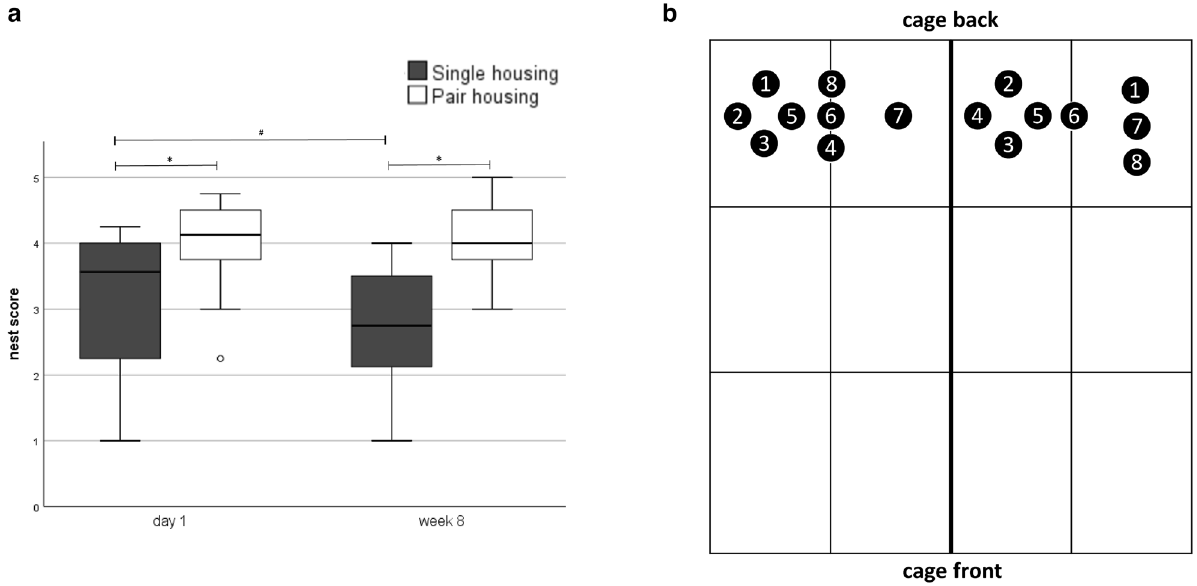
Figure 4. Nesting. ( a ) Nest complexity scores: Data are presented as boxplot diagrams: the box represents the interquartile range (IQR), box edges are the 25th and 75th quartile. The whiskers represent values which are not greater than 1.5 × IQR. Dots are outliers with values between 1.5 ‒ 3.0 × IQR. * p < 0.05 versus pair housing. Single housing: n = 16, pair housing: n = 16. ( b ) Nest positions in the pair housing system: the cage compartments were divided into six units. The numbers symbolize the unit/border where the nests were built. For nests of both mice of a pair, the same numbers were used ( n = 8